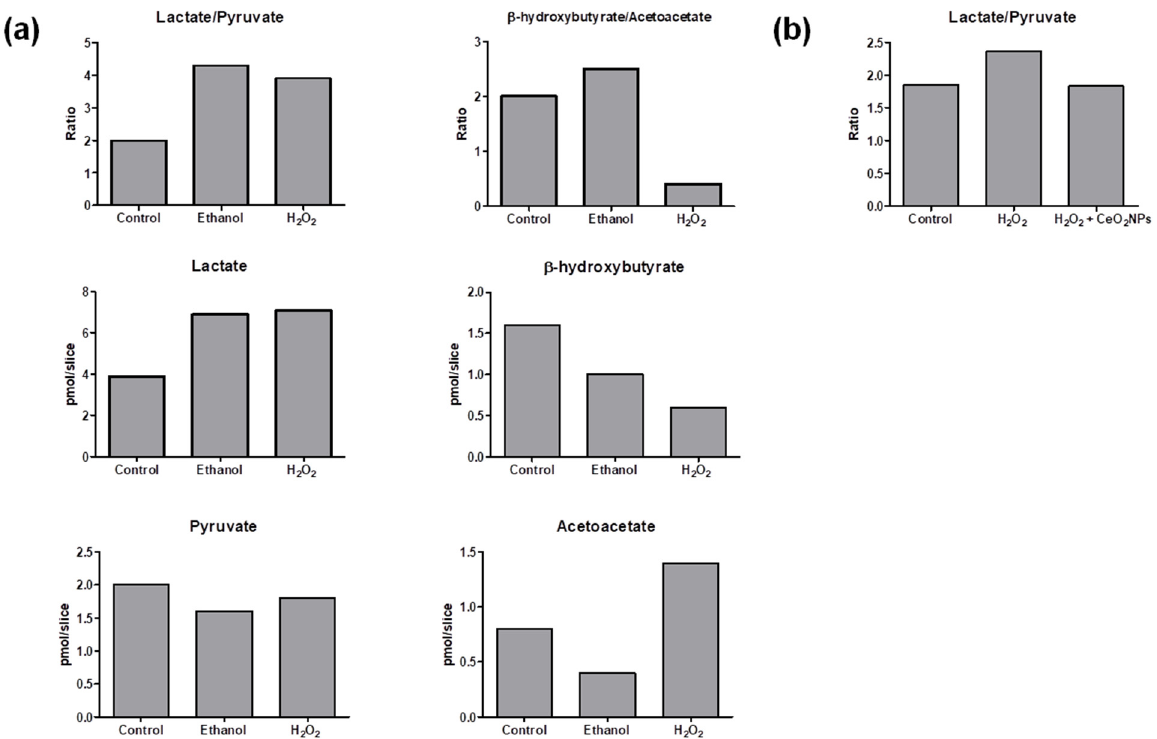
Figure 3. ( a ) Ratios of lactate/pyruvate and β -hydroxybutyrate/acetoacetate in precision-cut liver slices incubated under control conditions (control), exposed to ethanol (17 mM) or H 2 O 2 (1.5 mM). ( b ) Ratios of lactate/pyruvate in human hepatic cells (HepG2) cultivated under normal conditions (control), stimulated with 2 mM H 2 O 2 (H 2 O 2 ) and stimulated with 2 mM H 2 O 2 and treated with CeO 2 NPs (5 µg/mL) (H 2 O 2 + CeO 2 NPs).